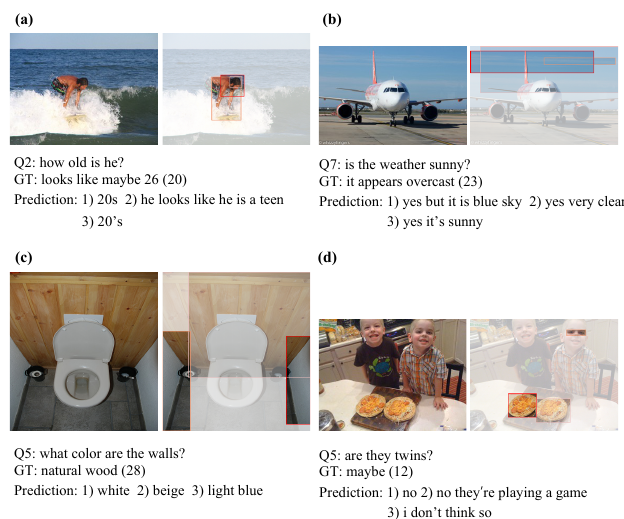
Figure 6. Error analysis on the VisDial v1.0 validation set. We analyze the examples for which the model scored 0 with respect to the R@10 metric. The Errors are categorized into (1) subjective judgment, (2) Ambiguous questions, and (3) Wrong multimodal alignment. ( a , b ) belong to the first, ( c ) to the second, and ( d ) to the third,